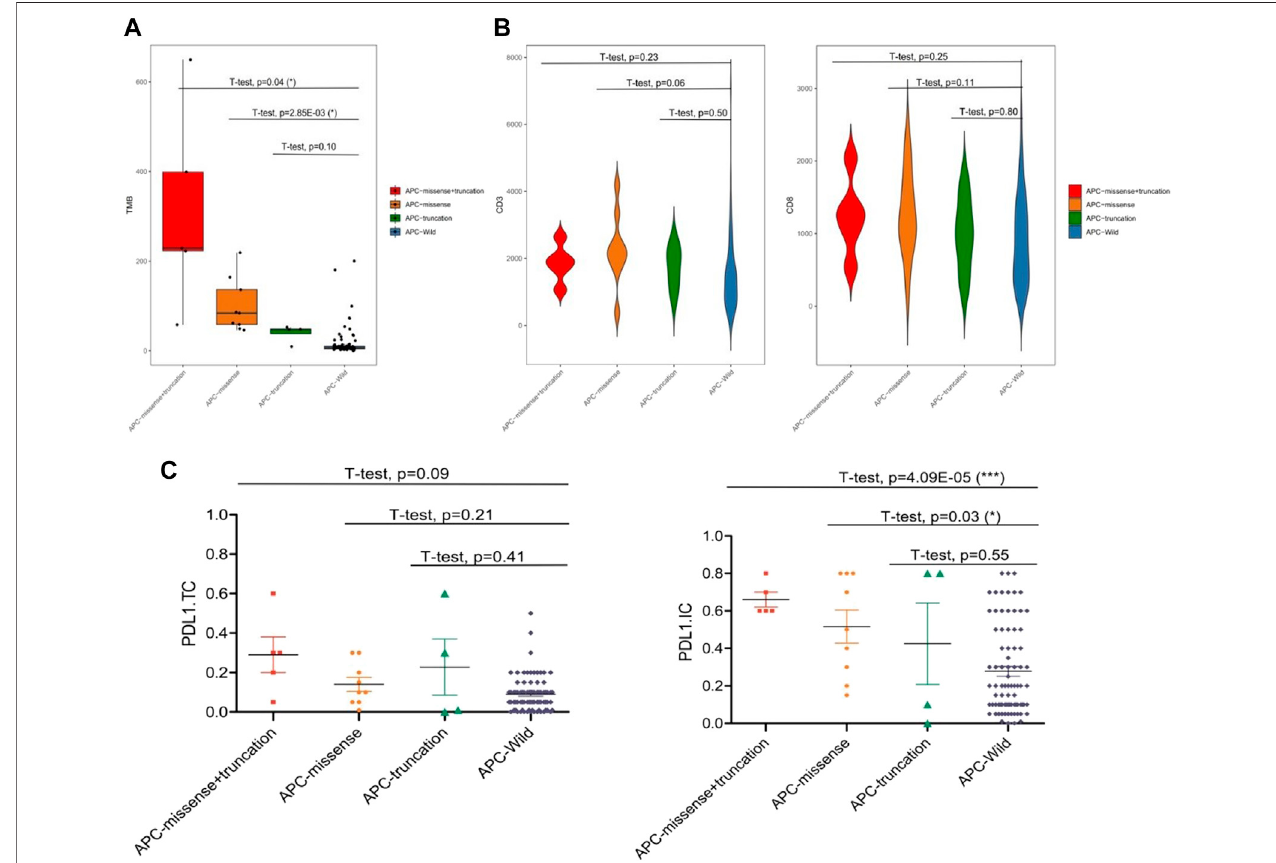
FIGURE5| CharacteristicoftheAPCmutationintheSFMIHcohort. (A) LevelofTMBinthesubtypesofAPC. (B) CD3 + andCD8 + Tcellin fi ltrationsinthesubtypes of APC. (C) PD-L1 expression in the subtypes of